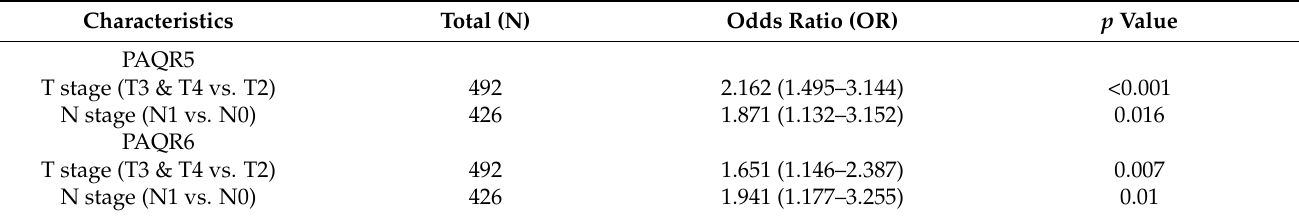
Table 3. Logistic Analysis of PAQR5/6 in Prostate